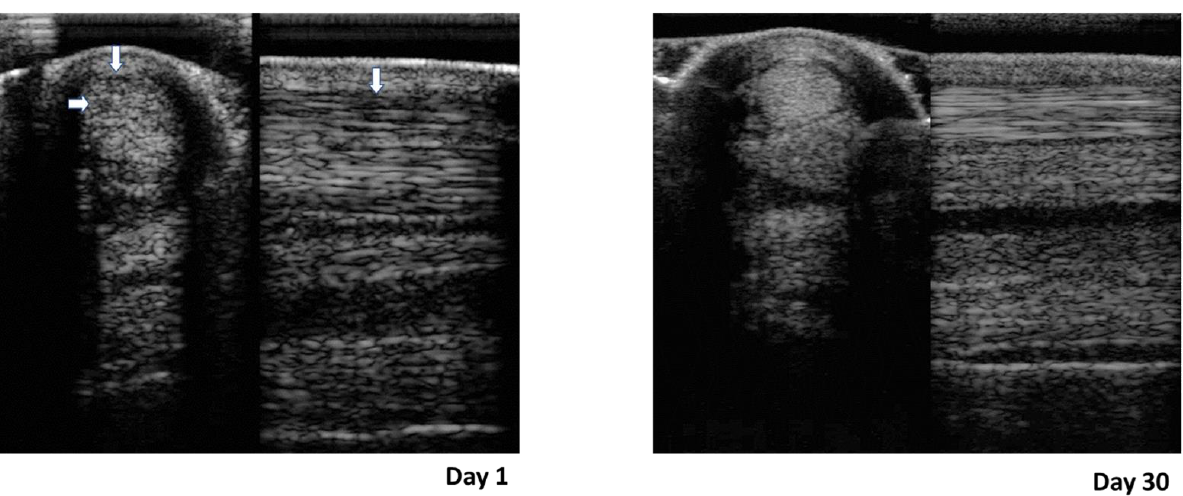
Figure 10. Ultrasound images of Case numbers 4, 14, and 16 that represent the clinical cases concern- ing superficial digital flexor tendon (SDFT). Transversal and longitudinal images at Day 1 and at Day 30 after first treatment with eSM-MSCs. These ultrasounds are representative of the cases and very illustrative of good fiber alignment and cross-sectional area reduction, evidencing tissue